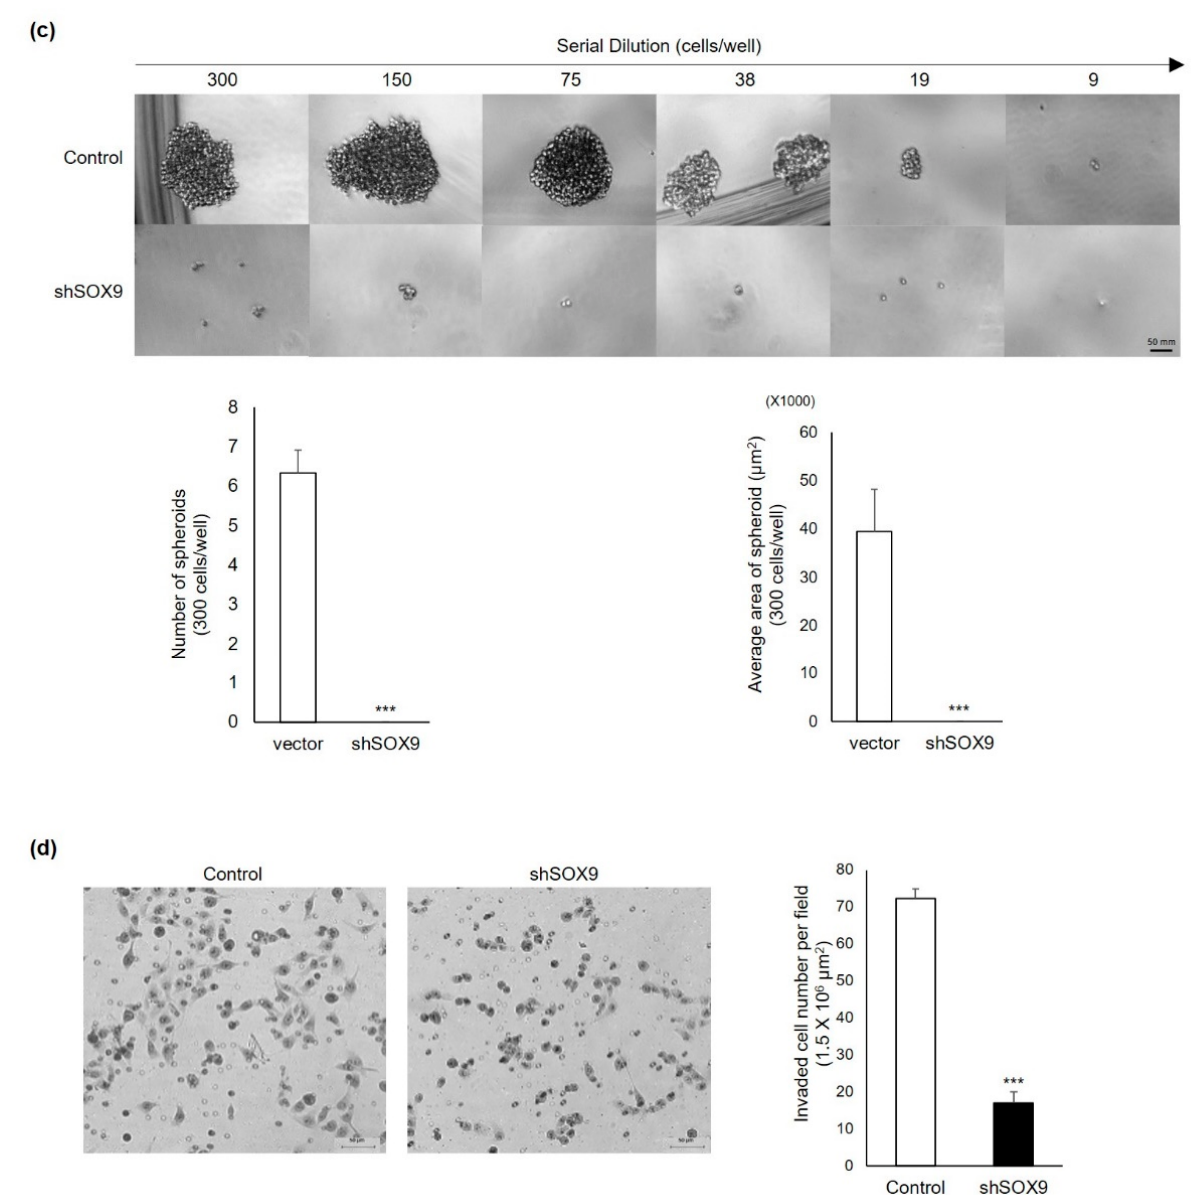
Figure 3. Silencing of SOX9 in human ovarian 2774 cancer cells with high SOX9 expression resulted in loss of cancer stem-like properties. ( a ) SOX9 silencing strongly suppressed ALDH1A1 mRNA expression measured by qRT-PCR analysis. Control 2774 cells and 2774-Sox9sh cells harboring vector alone and SOX9- specific shRNA(sh1) were harvested to extract the total RNA for qRT-PCR assay to measure ALDH1A1 mRNA expression. ( b ) Reduction in ALDH activity by SOX9 knockdown. ALDH1 activity was analyzed by Aldefluor assay. ( c ) Spheroid formation was blocked by SOX9 knockdown in 2774 cells. Using 3D cell culture conditions, 2774-control cells formed discrete and compact spheres, whereas 2774-Sox9shRNA cells failed to form spheres. ( d ) Suppression of cancer cell invasion by SOX9 knockdown. Control vector 2774 and 2774-shSOX9 cells were seeded onto Transwells on Matrigel-coated Transwells. The number of invaded cells was counted under a light microscope, and mean values were plotted. Data present the mean ± SD of three independent experiments. *** p < 0.001 indicate significant